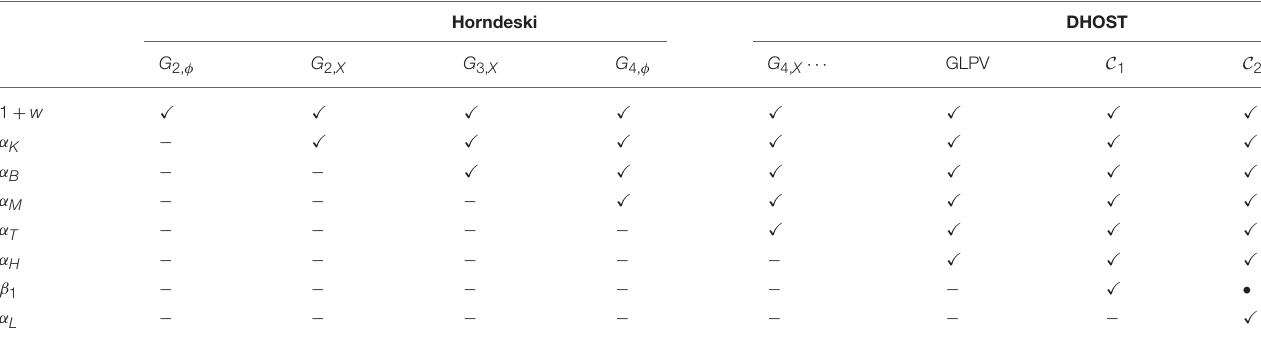
TABLE 1 | EFT functions in scalar-tensor theories: a hierarchy exists by which more complex theories of gravity (left to right) produce a larger set of effects (more non-zero functions). Horndeski DHOST G 2, φ G 2, X G 3, X G 4, φ G 4, X GLPV C 1 C ···